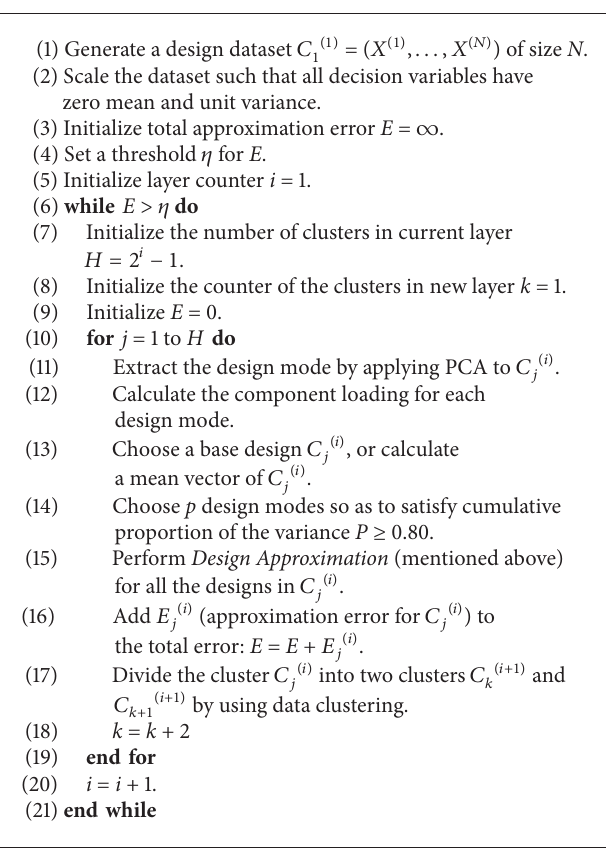
Algorithm 2: Design mode analysis focusing on granularity.